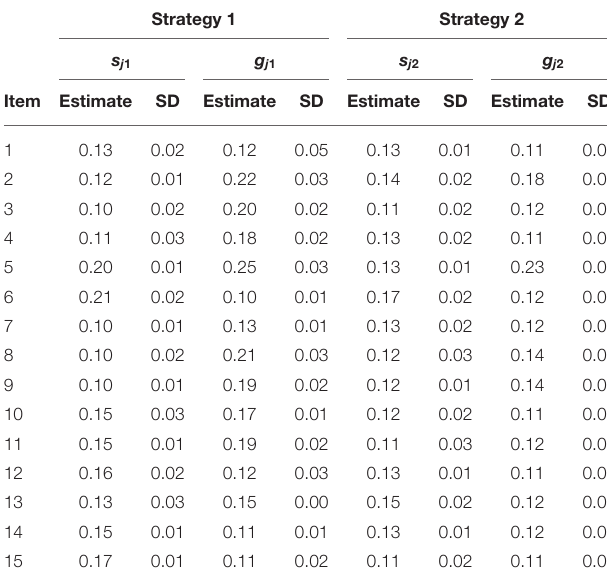
TABLE 7 | MMS-DINA model parameter estimates for the fraction subtraction data. Strategy 1 Strategy g 1